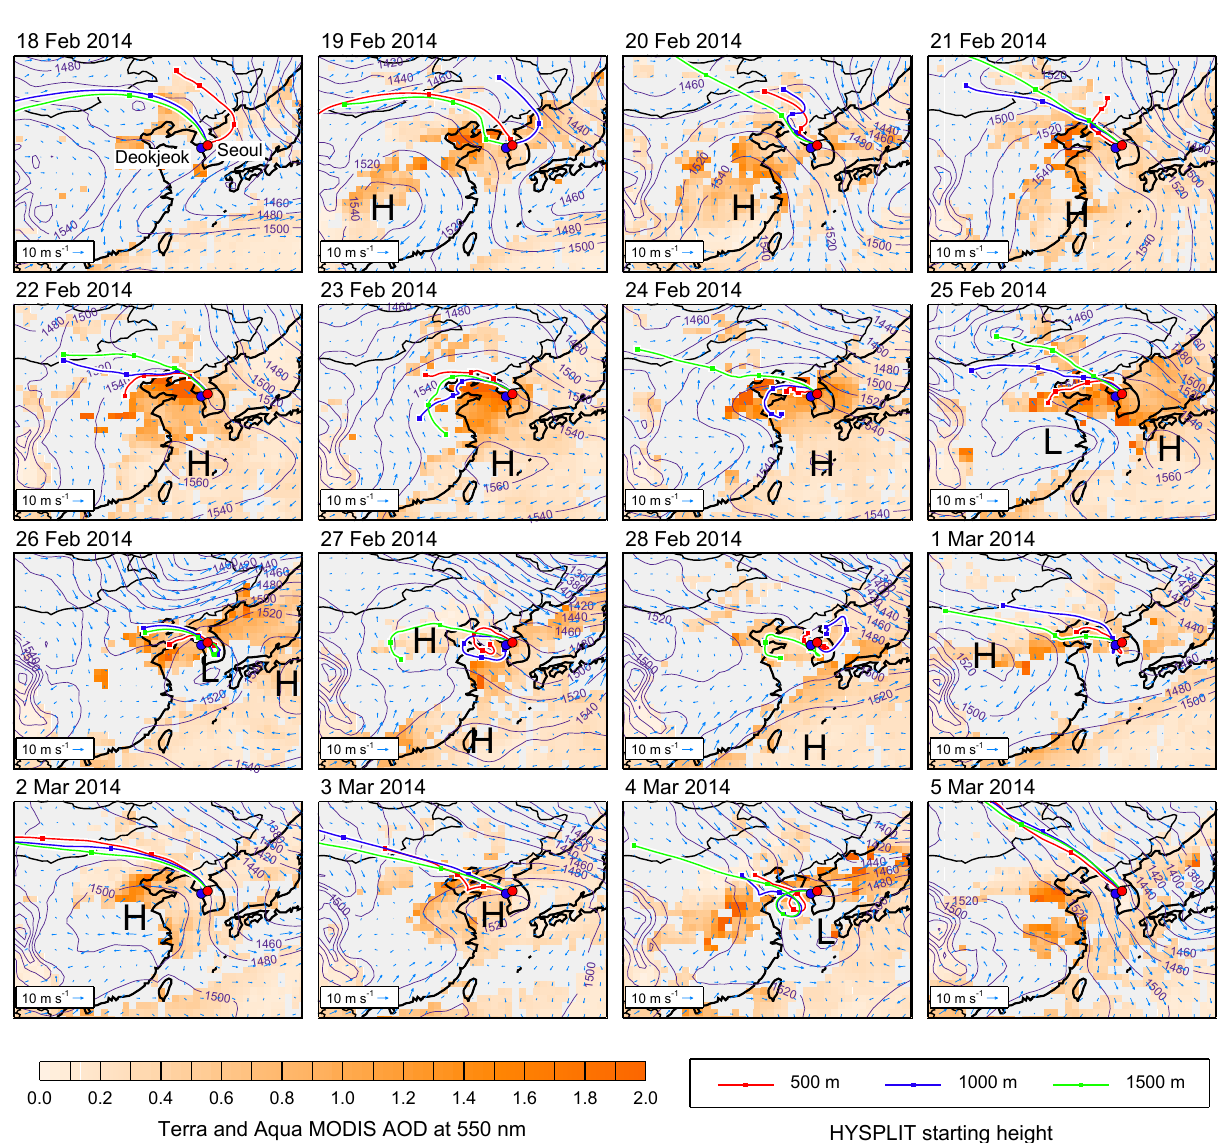
Figure 8. Daily evolution of synoptic meteorological conditions over East Asia during the multiday haze episode in 2014. ERA-Interim daily mean geopotential height (contours; unit of gpm) and wind (arrows) at 850hPa are superimposed on the Terra and Aqua MODIS AOD at 550nm. The red, blue, and green lines with squares respectively represent backward trajectories from 500m, 1000m, and 1500ma.s.l. over the sampling site at 21:00 local time (GMT + 09:00) on each day with endpoints at a 24h